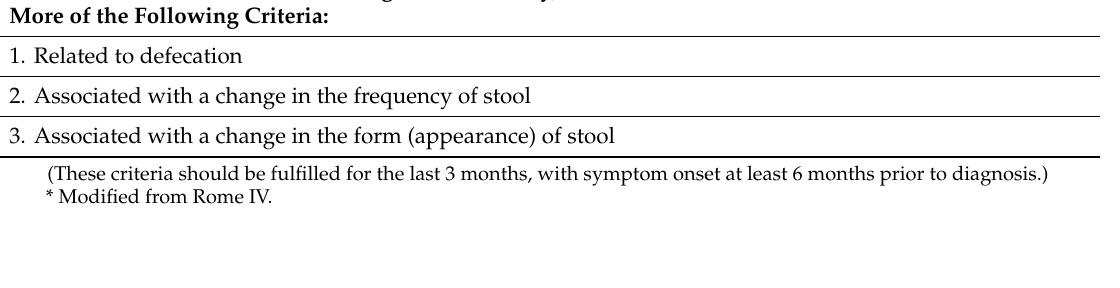
Table 1. Irritable bowel syndrome (IBS) diagnostic criteria